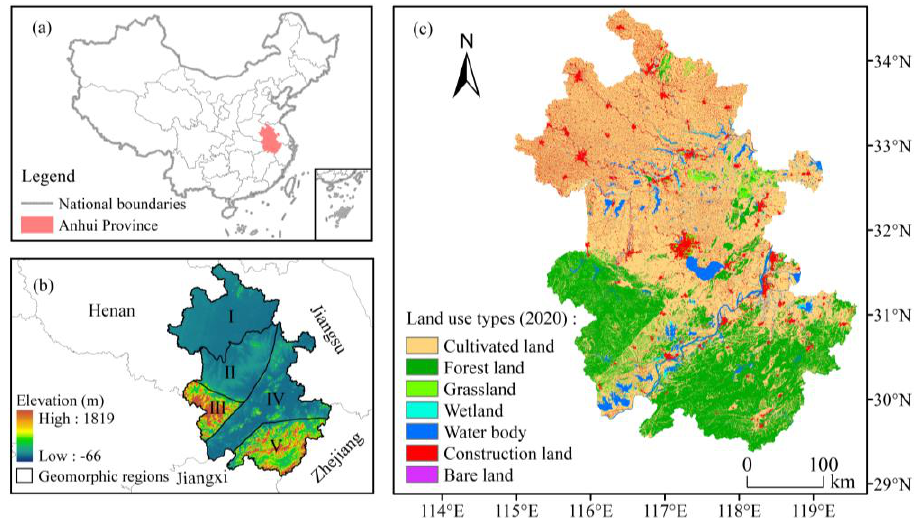
Figure 1. ( a ) Location of Anhui Province, China; ( b ) elevation and geomorphic zoning: I: Huaibei Plain; II: Jianghuai Plain; III: Dabieshan Mountain in West Anhui; IV: a hilly plain in the Yangtze River region; V: mountains in South Anhui; and ( c ) land use of the study area in 2020.